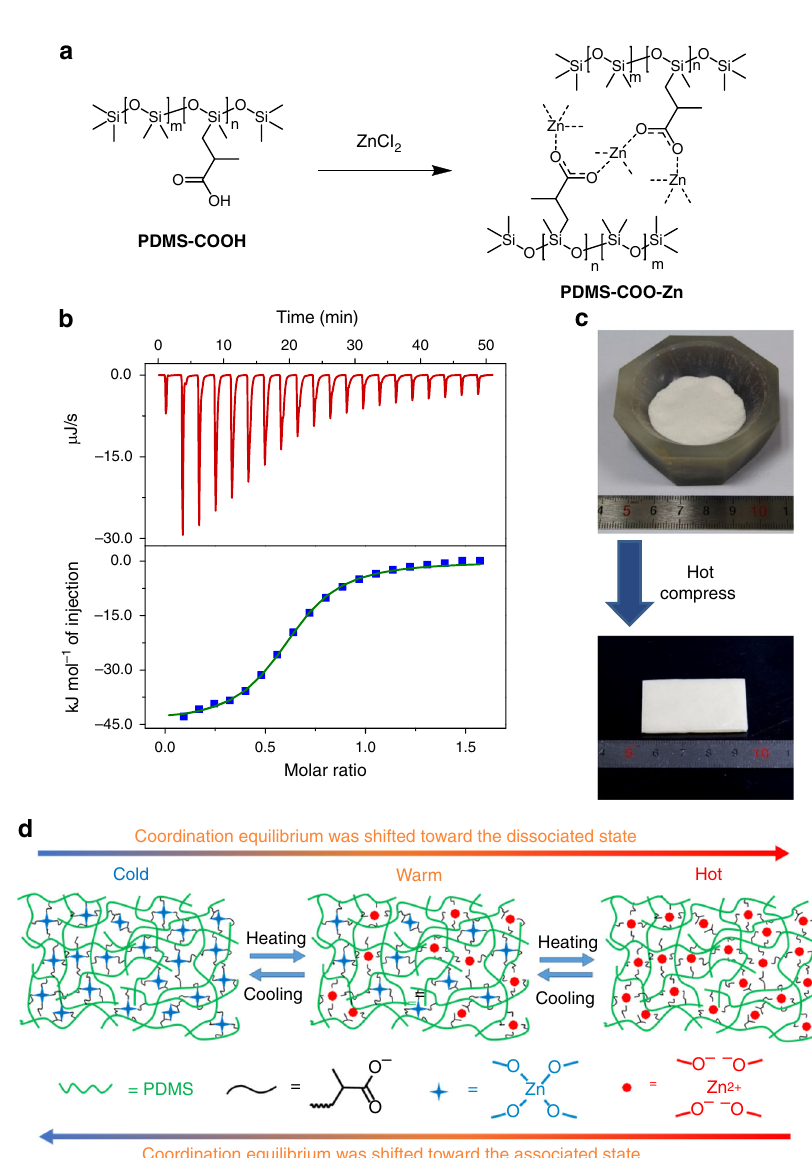
Fig. 1 Preparation and characterizations of PDMS-COO-Zn polymer. a Synthesis and structure of PDMS-COO-Zn polymer. b The ITC titration data of the PDMS-COO - with ZnCl 2 in anhydrous ethanol at 25 °C. c Hot compressing of the powder lead to the block sample. d Schematic structure of the polymer network at different